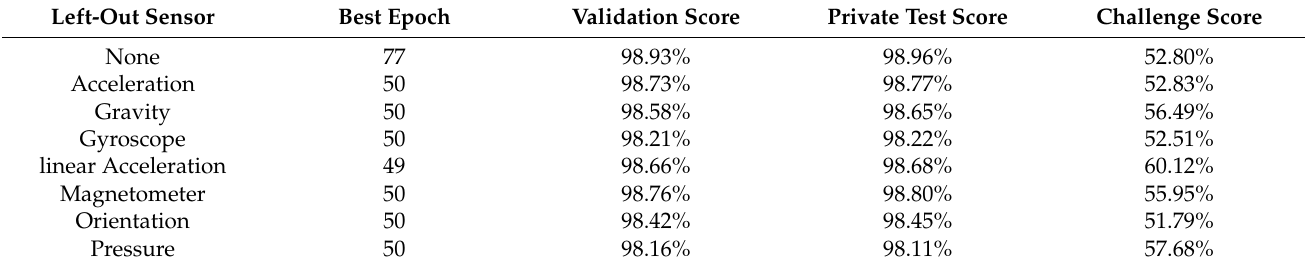
Table 2. An overview about the change of the scores for each class and left-out sensor. The smallest drop in accuracy is marked in green and the largest drop in red.